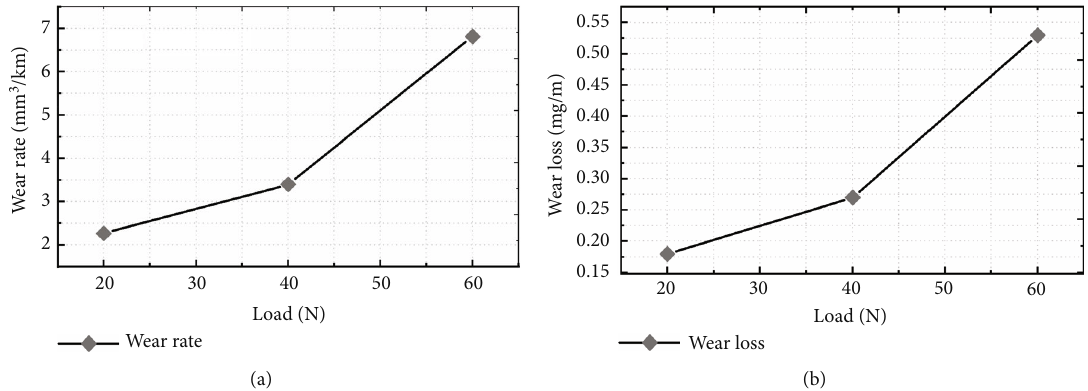
Figure 1: The in fl uence of load for a sliding speed of 100 rpm on (a) the wear volume of rail steel and (b) weight loss values of rail steel material